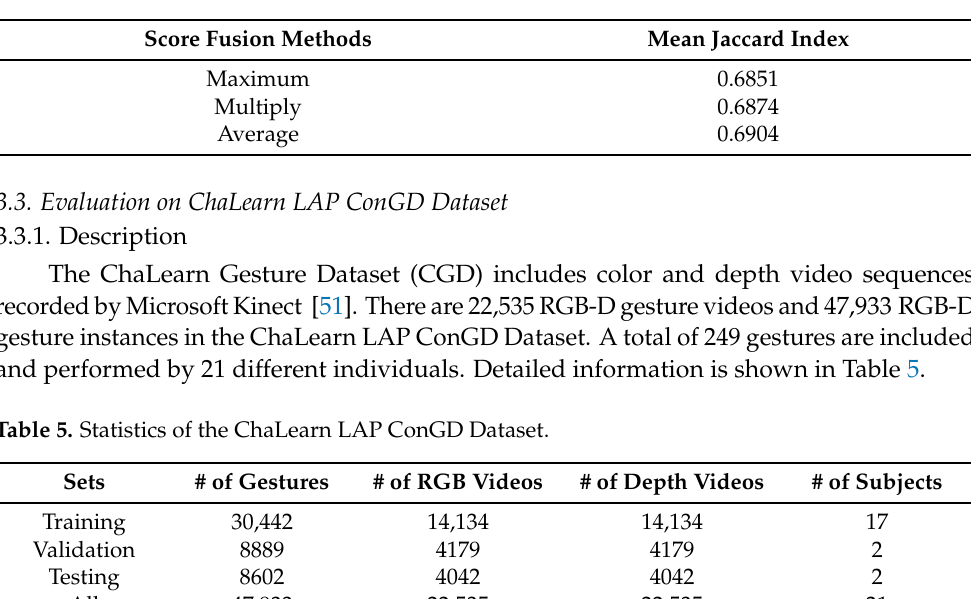
Table 4. Comparison of three different score fusion methods on the validation set of ChaLearn LAP ConGD Dataset.